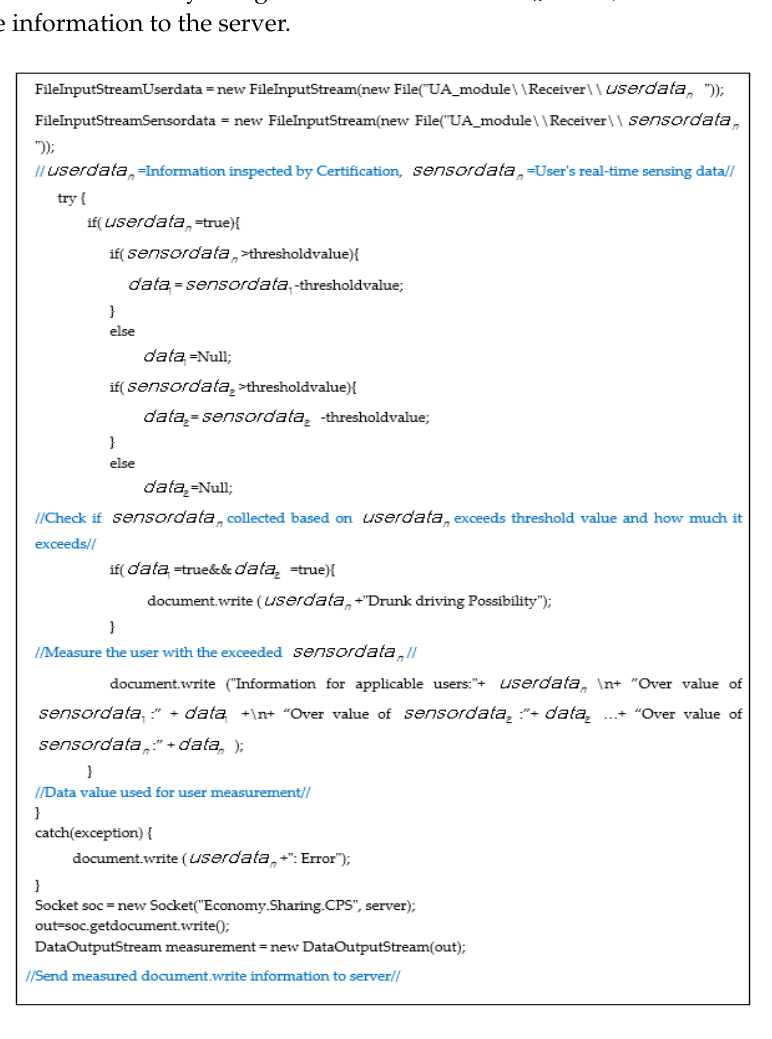
Figure 11. Design algorithm of the system.